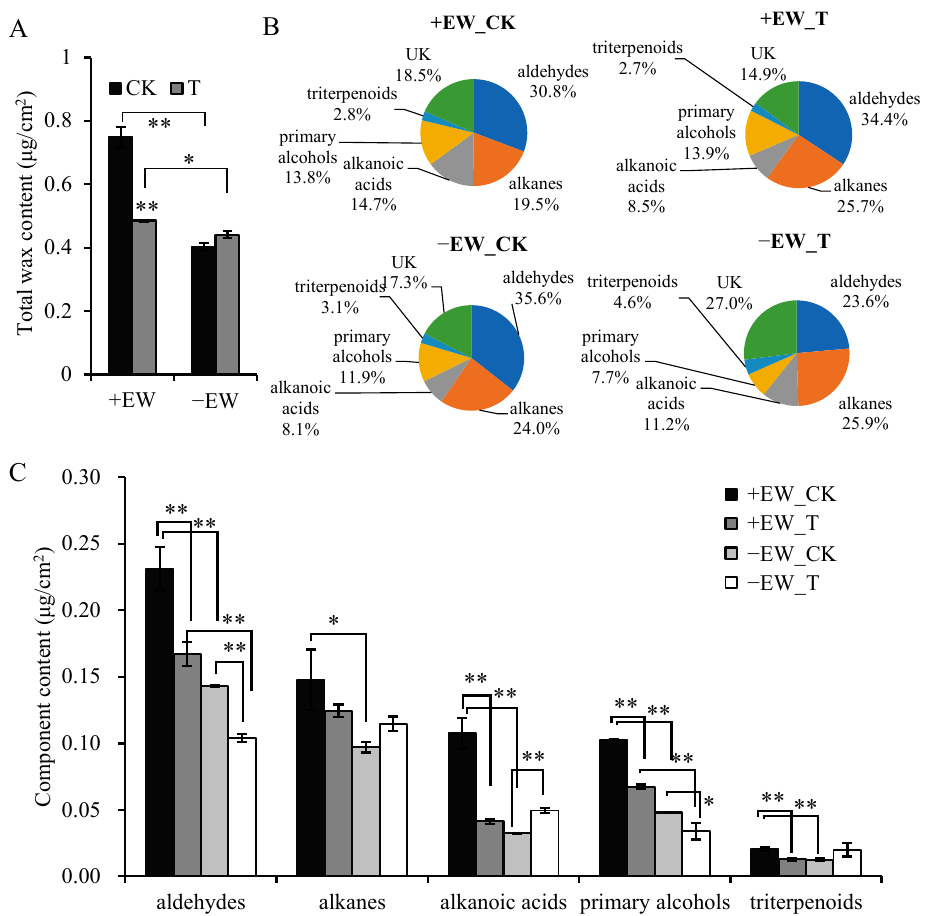
Figure 4. Responses of sorghum leaf wax monomer profiles to anthracnose infection. ( A ) Total wax amounts of leaves sampled from anthracnose infection of sorghum with or without epicuticular wax. ( B ) Pie plot of relative abundance of leaf wax monomer classes. ( C ) Relative abundance of individual compounds within wax monomer classes of alkanoic acids, aldehydes, primary alcohols, triterpenoids, and alkanes. Bars with one star (*) or two stars (**) are significantly different at p ≤ 0.05 or p ≤ 0.01, by a one-way analysis of variance with Duncan’s multiple range test, respectively. Values are means ± SE ( n = 6).